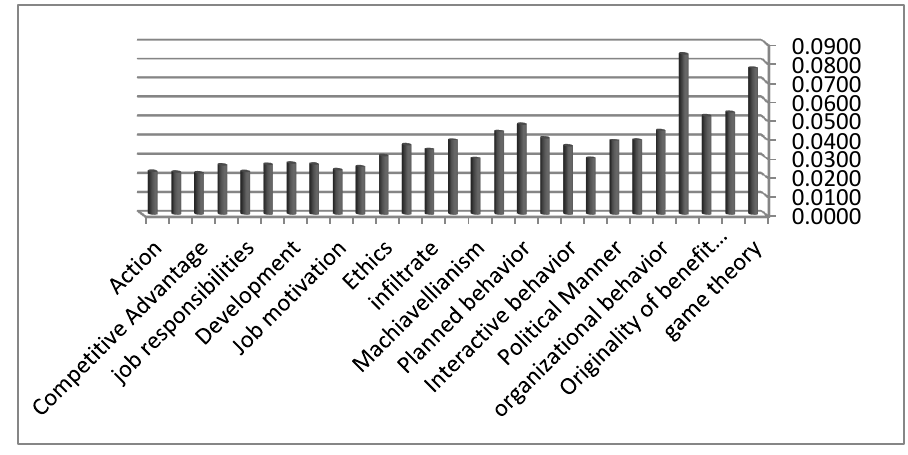
Fig. 5. Superdesizhen software output to prioritize key